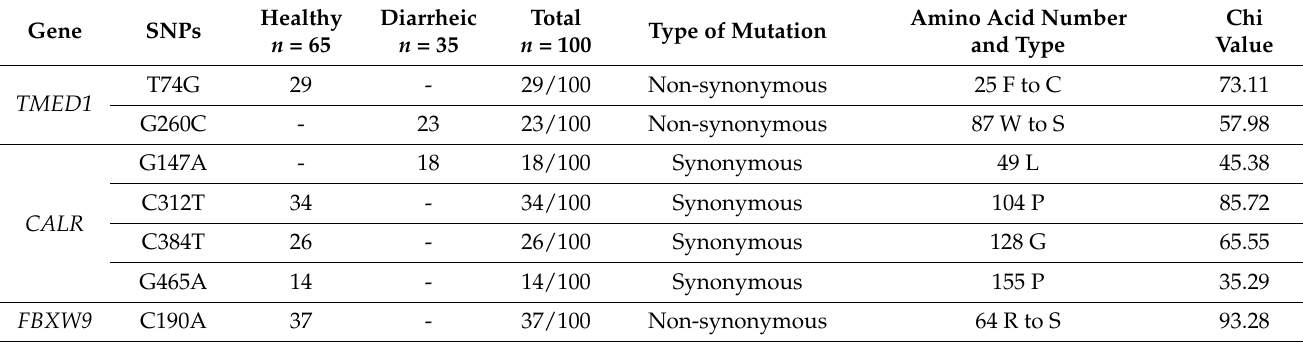
Table 3. SNP distribution and kind of mutation for the genes under investigation in diarrheal and healthy Baladi